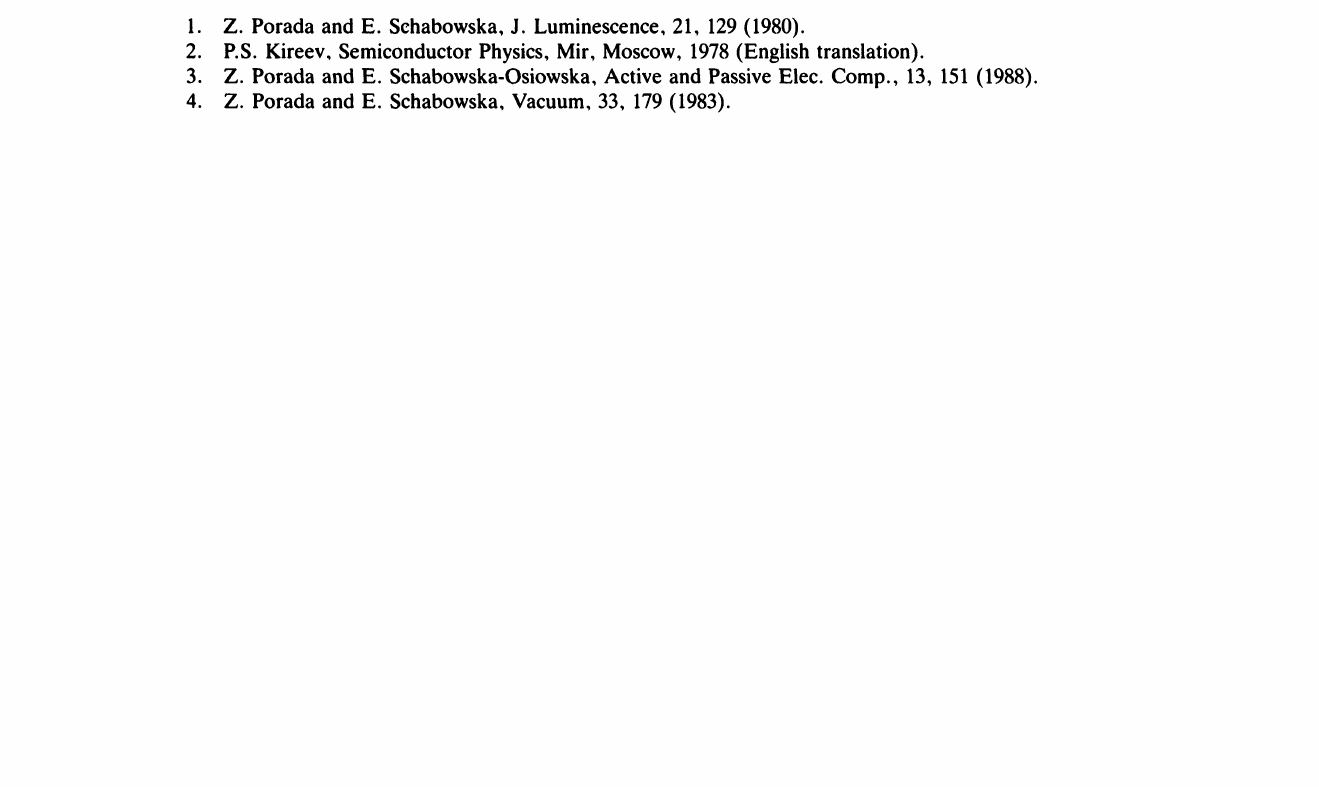
,, on the frequency of supplying voltage U